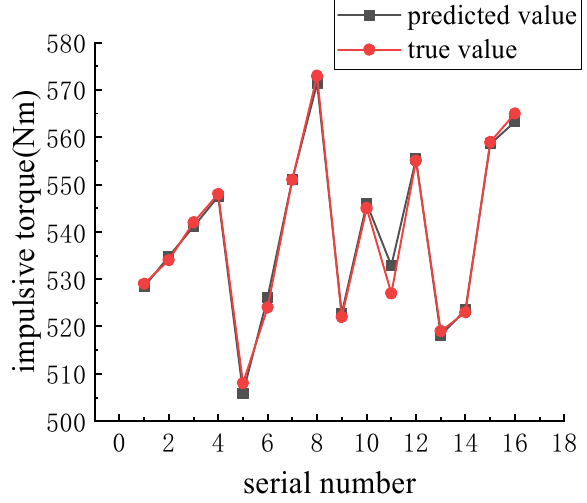
Figure 28. Prediction results of the impact torque, SVR.